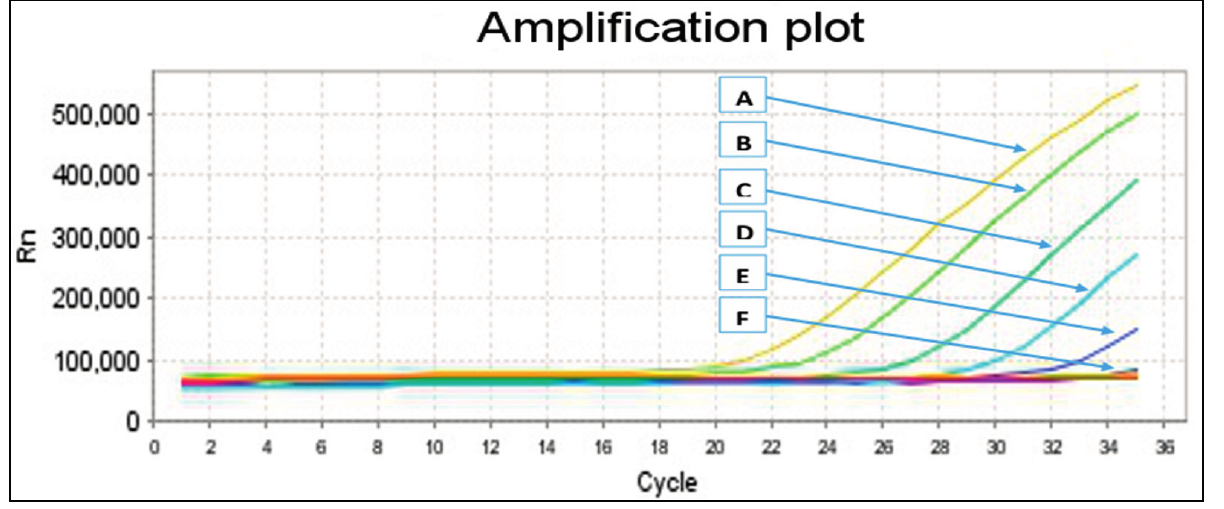
Figure 1. Sensitivity test. A = 10 − 1 , B = 10 − 2 , C = 10 − 3 , D = 10 − 4 , E = 10 − 5 ,